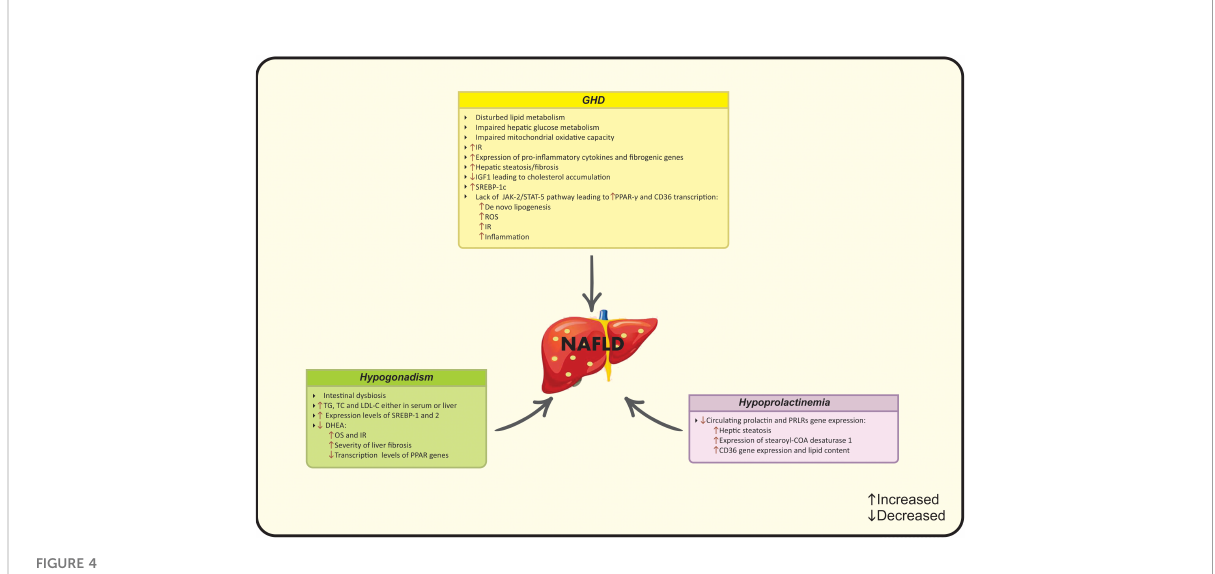
FIGURE 4 Possible mechanisms of hypopituitarism on NAFLD development. CD36, Cluster of differentiation 36; COA, Coenzyme A; DHEA, Dehydroepiandrosterone; IGF-1, Insulin-like growth factor-1, IR, Insulin resistance; JAK2, Janus kinase 2; LDL-C, Low-density lipoprotein cholesterol; NAFLD, Nonalcoholic fatty liver disease; OS, Oxidative stress; PCOS, Polycystic ovarian syndrome; PPAR, Peroxisome proliferator- activated receptor; PRLR; Prolactin receptor; ROS, Reactive oxygen species; SREBP, Sterol regulatory element- binding protein; STAT-5, Signal transducer and the activation of activator of transcription 5; TC, Total cholesterol; TG,